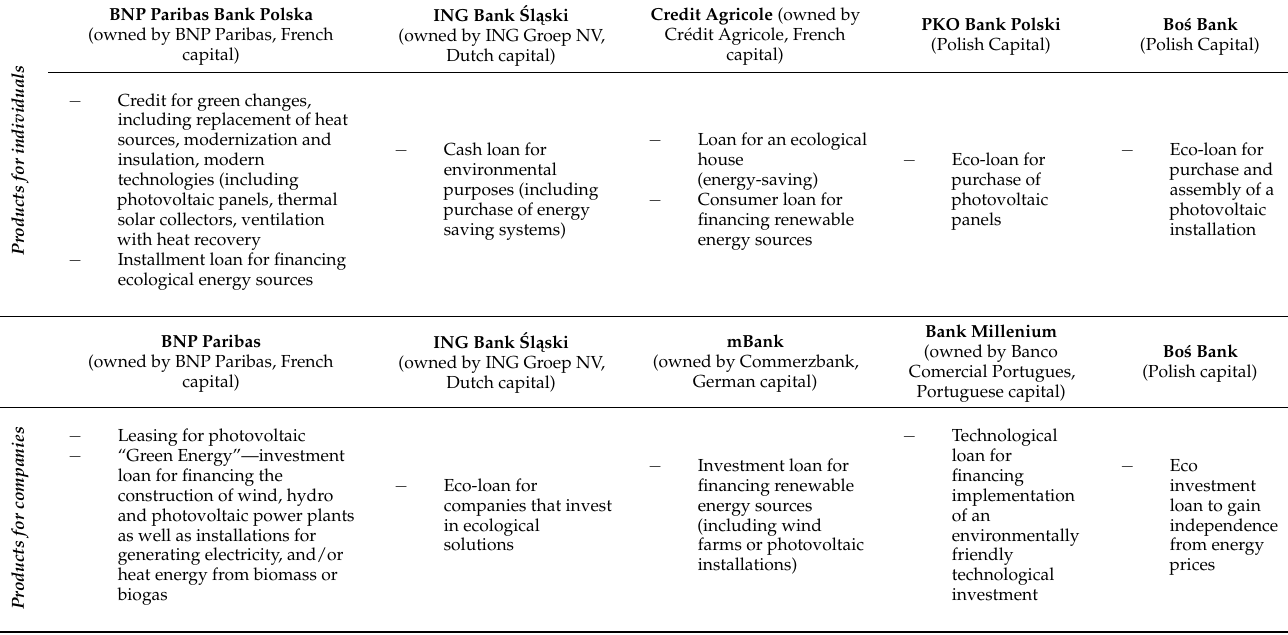
Table 1. “Green” credit products included in the lending offer of commercial banks in Poland (source: own work).